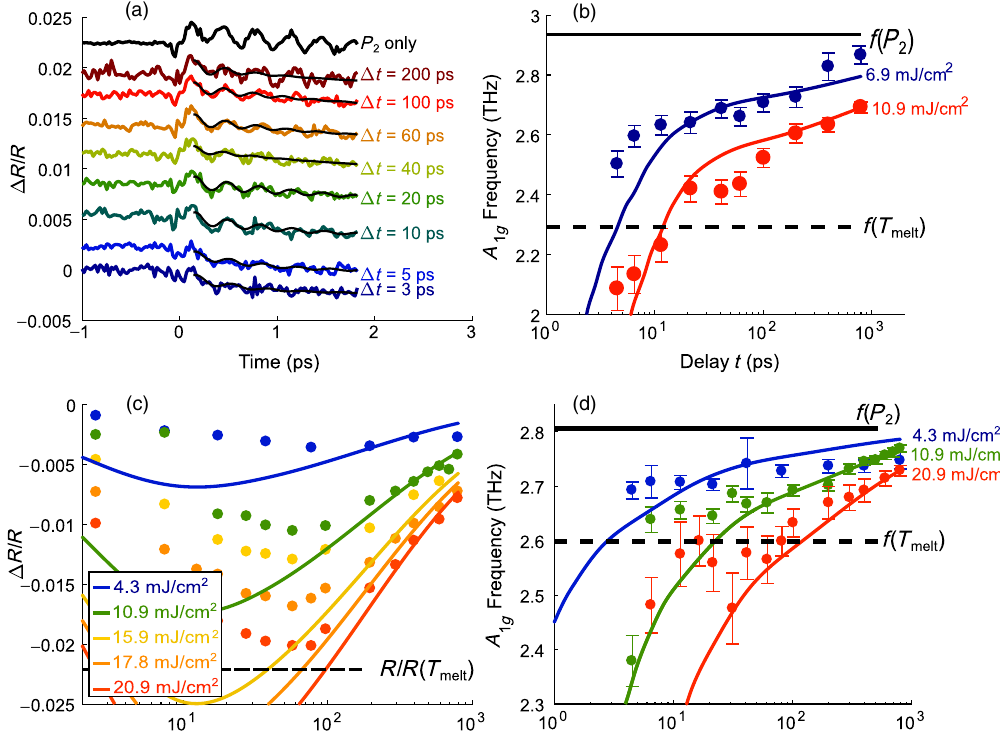
FIG. 3. Two-pulse experiments on the highly excited state of the 275-nm bismuth film. (a) Single-shot traces following an initial excitation pulse ( P 1 ) of 10 . 9 mJ = cm 2 and a second excitation pulse ( P 2 ) of 1 mJ = cm 2 on a 275-nm film at 80 K. The coherent phonon signal is suppressed 3 ps after the first excitation pulse and returns 20 ps later. Δ t is the time delay between the two excitation pulses. The probe wavelength for this experiment is 720 nm. (b) Coherent phonon frequency as a function of the time delay between an initial excitation pulse with an incident fluence of 6.9 and 10 . 9 mJ = cm 2 and a second excitation pulse with an incident fluence of P 2 ¼ 1 mJ = cm 2 . The solid lines are the predicted oscillation frequency based on an extended two-temperature model. Within 1 ps after excitation at 10 . 9 mJ = cm 2 , no phonon oscillations are induced by a weak second excitation pulse, indicating that the irradiated region of the film is in the symmetric phase. (c) The transient reflectivity of the Bi film at 300 K as a function of time after excitation for various pump fluences with an 800-nm probe. Note the logarithmic timescale. Points are measurements made at selected long times averaged over the 9-ps time window of the single-shot instrument. Solid lines are calculations based on an extended two-temperature model and the known thermoreflectance of bismuth. The simulations do not account for the reflectivity change due to hot carriers, and so are Þ corresponds to the relative reflectivity expected to agree only with the experiment at a long delay. The dashed line labeled Δ R=R ð T melt ¼ 544 K. (d) Transient A difference of bismuth at its initial temperature of 300 K and its melting point T 1 g frequency measured using melt the same method as in (b) for the sample starting at 300 K for three representative pump fluences. The solid line labeled f ð P 2 Þ corresponds to the coherent phonon frequency observed by the weak pump pulse in the absence of the strong pump P 1 . The dashed line indicates the expected A 1 phonon frequency for bismuth heated to its melting g